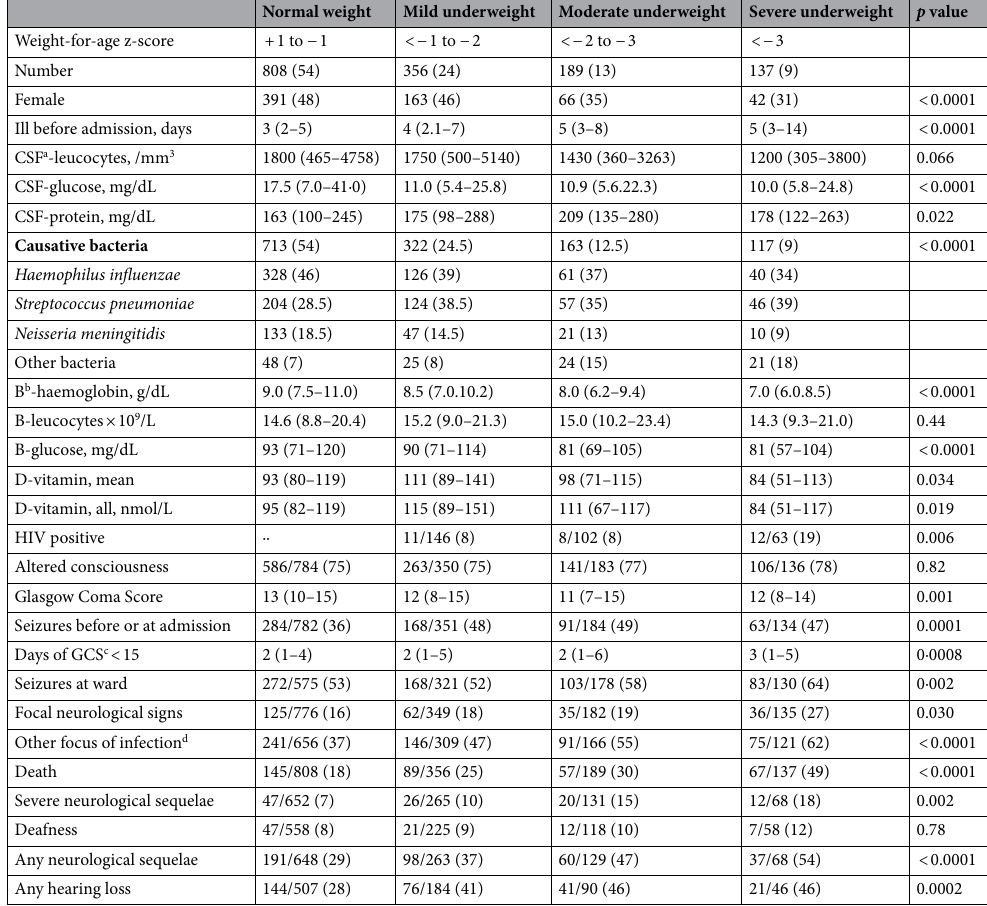
with the condition/all examined (percentage) and compared between the categories using contingency table or Kruskal–Wallis test, as appropriate. a Cerebrospinal fluid. b Blood. c Glasgow Coma Score. d Pneumonia,or cellulitis, or otitis media, or